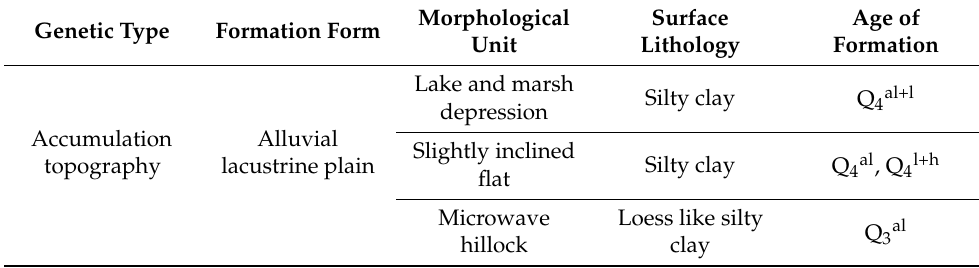
Table 1. Brief list of geomorphic